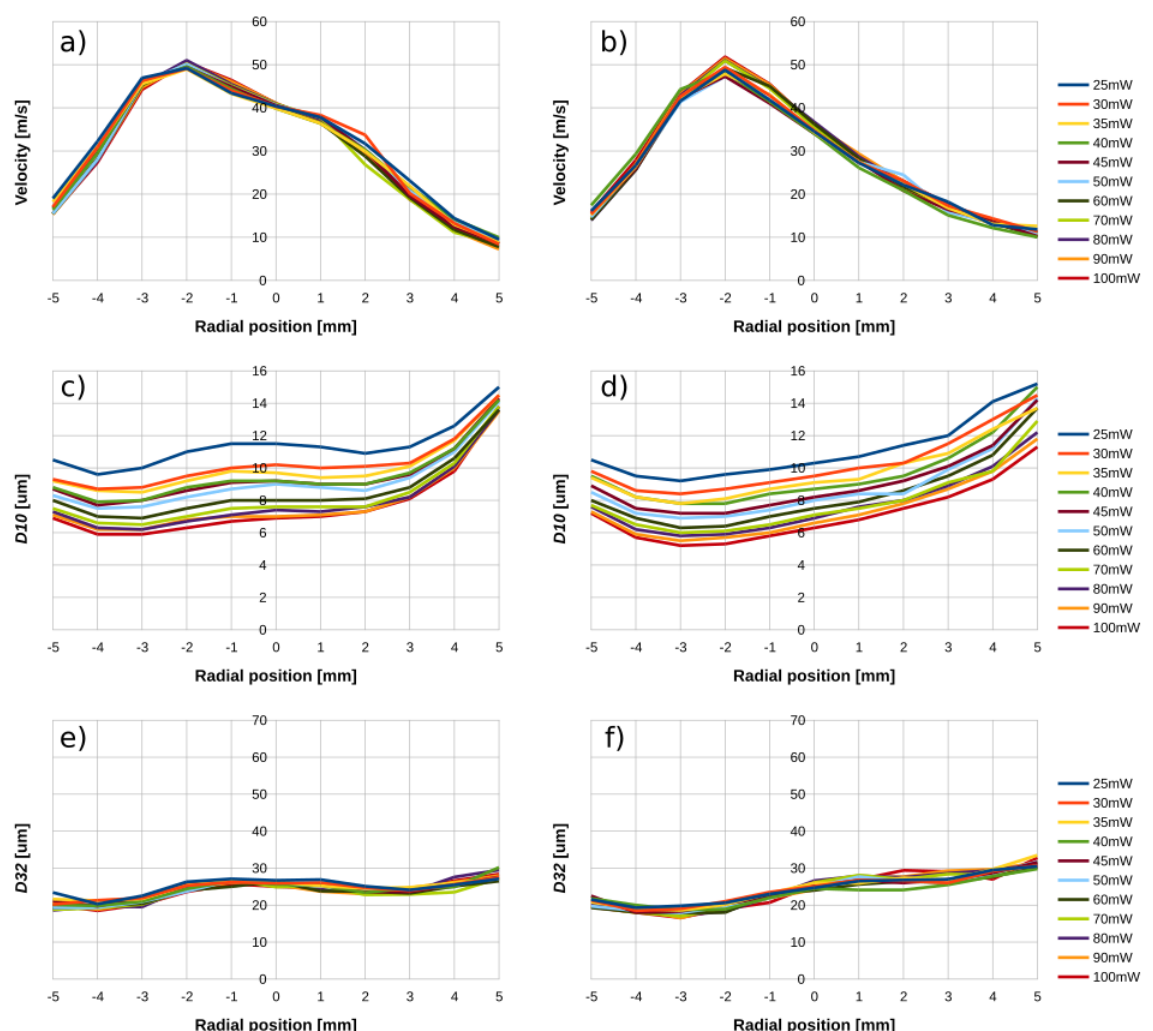
Fig. 5 . Effect of laser power. From top: radial profiles of mean axial velocity in the axial distance of 10 mm from the nozzle, radial profiles of D10 and radial profiles of D32 . Left: system A. Right: system